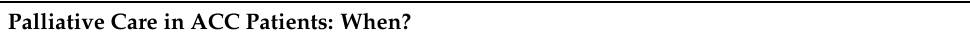
Table 1. When and why to consider primary or secondary palliative care for patients with ad- vanced